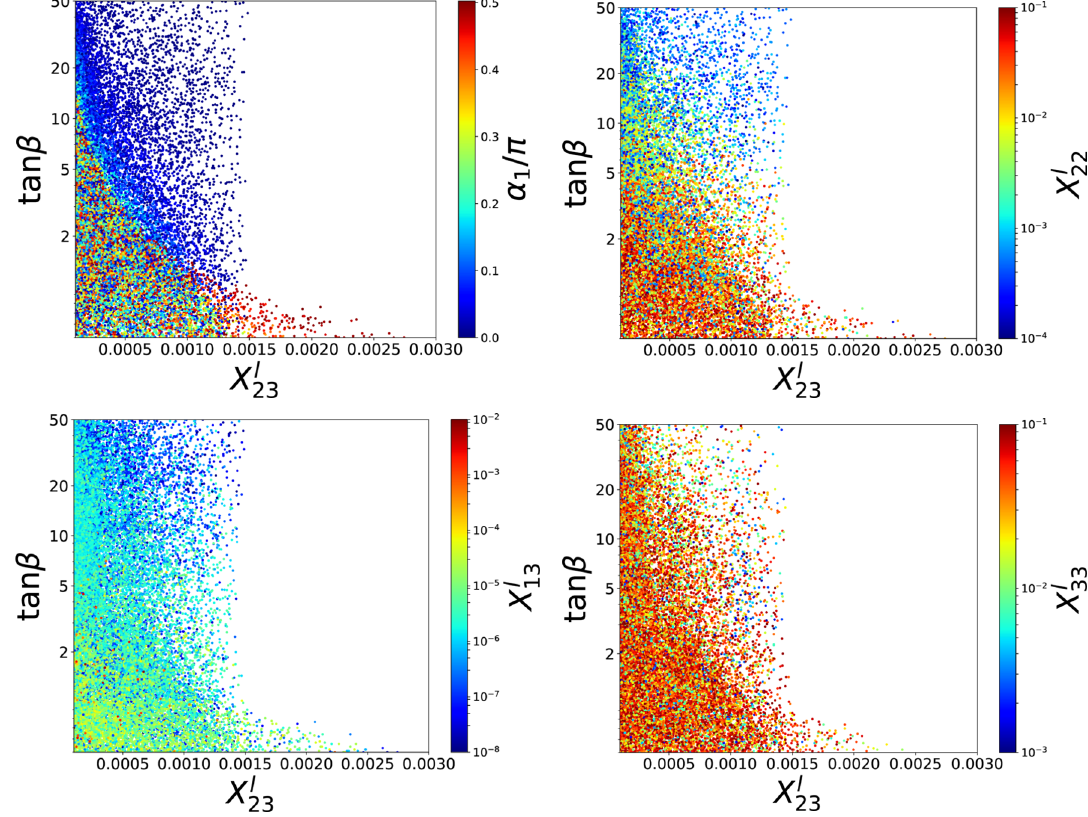
Figure 6 . The allowed parameter region satisfying constraints from BR ( h 0 → µτ ) , BR ( τ → 3 µ ) , BR ( µ → eγ ) and BR ( τ → µγ ) .